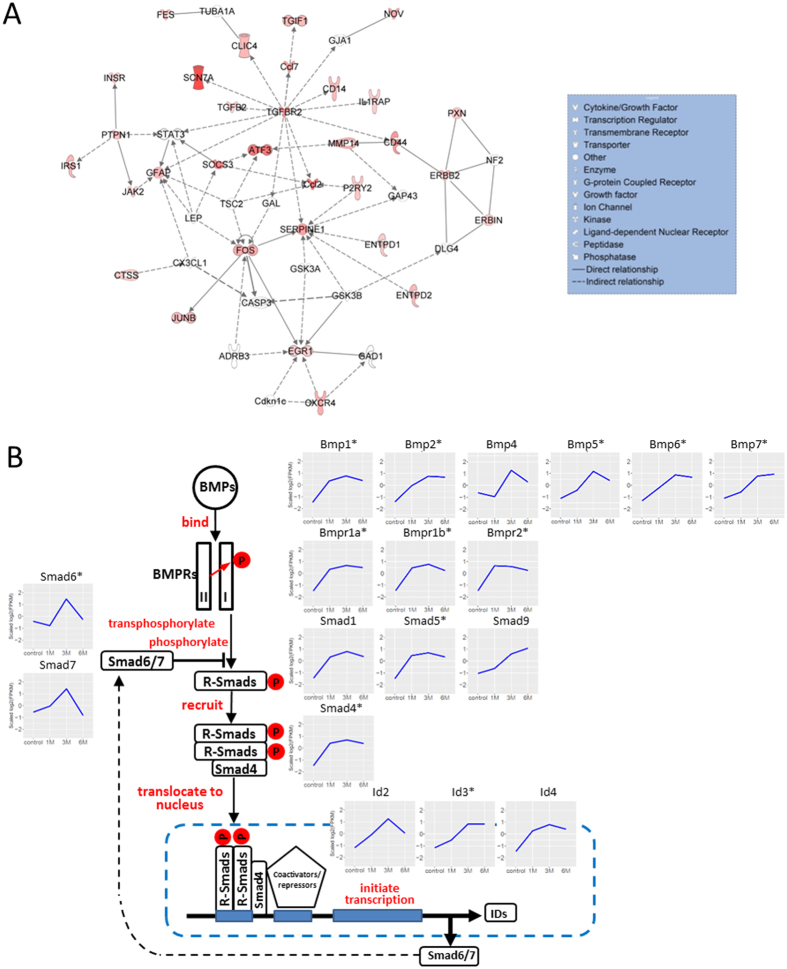
Enriched network and canonical pathway generated with DEGs that are important in chronic SCI.(A) One of the most enriched networks generated in IPA with 1 M/3 M/6 M overlapping DEGs. (p-score = 14 or p-value = 10−14). DEGs were colored-coded, with shades of red indicating the level of upregulation. Stat3 was differentially expressed at 1 M and 3 M, after which it was marginally upregulated at 6 M (FC = 1.97). (B) A schematic illustration of gene expression profiles (log2-transformed FPKM) of members of the canonical Bone Morphogenetic Protein (BMP) pathway73 at different time points post-SCI. Genes coding for BMP ligands (BMP1, 2, 4, 5, 6 and 7), BMP receptors (BMPR1A, BMPR1B and BMPR2), SMADS (SMAD1, 5 and 9), transcriptional activator (SMAD4), and IDs (ID2, 3 and 4) exhibited upregulation in chronic SCI. Downstream target genes (such as Olig1 and Olig2) showed a gradual downregulation pattern. Genes coding for inhibitory SMADS (SMAD6 and 7) displayed a transient upregulation peaking at 3 M and returning to basal levels at 6 M. *Indicates differentially expressed genes.